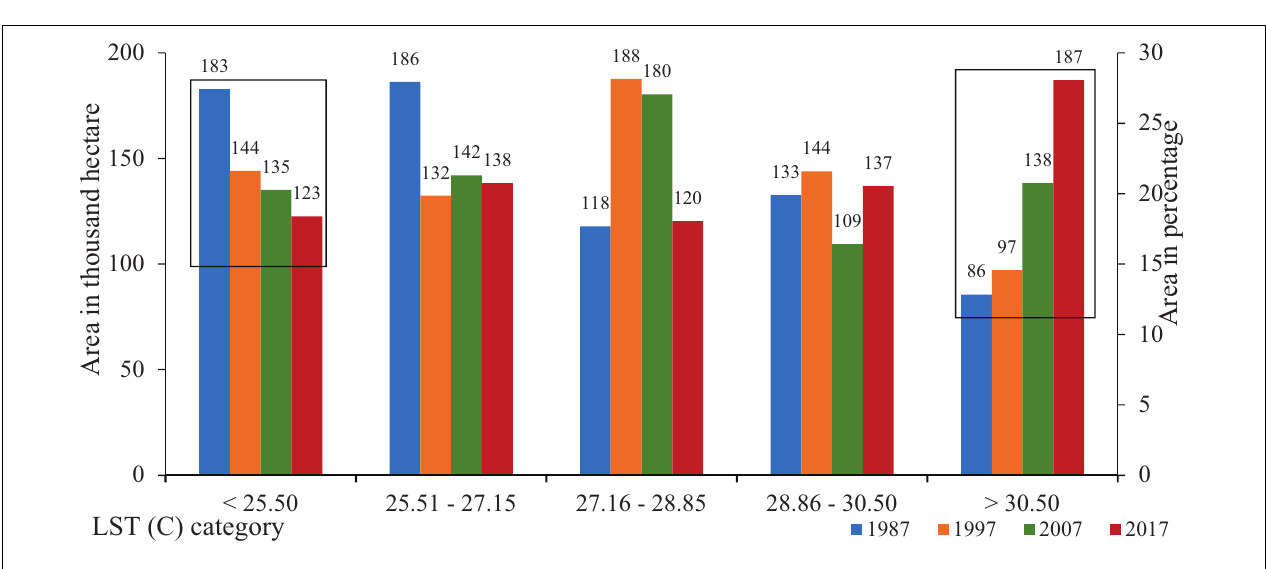
Frontiers in Environmental Science |